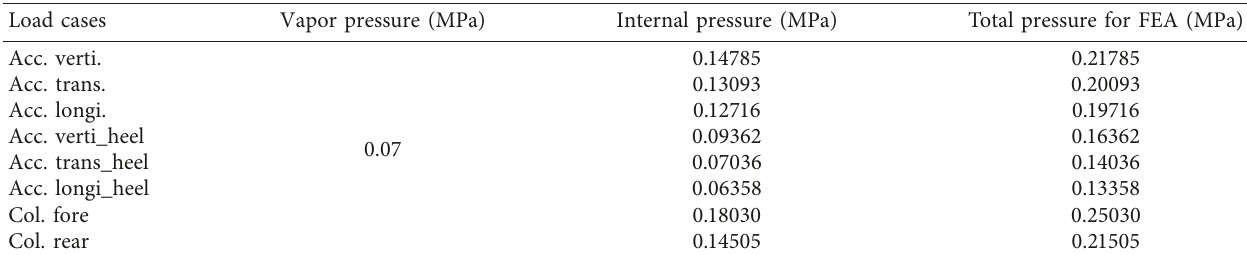
Table 6: Results of the loading calculation.